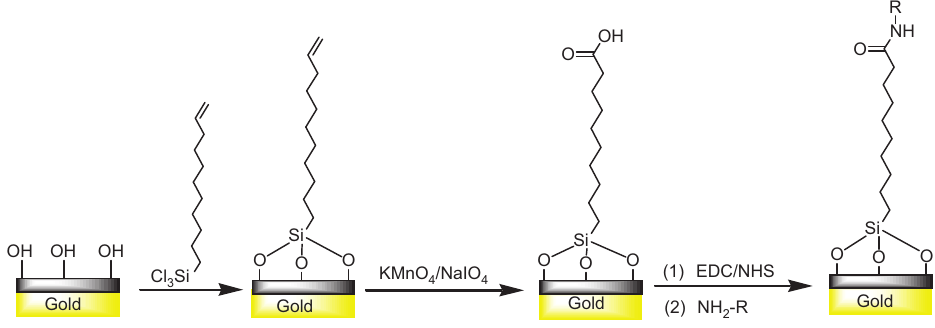
Figure 11 Schematic illustration of the carboxylation of oxide-based overlayers such as ITO and SnO mixture [CH ]/([SiH ] + [CH ]), the fi nal carbon (C) content in 4 4 4 the material, and thus the optical properties, can be adjusted.